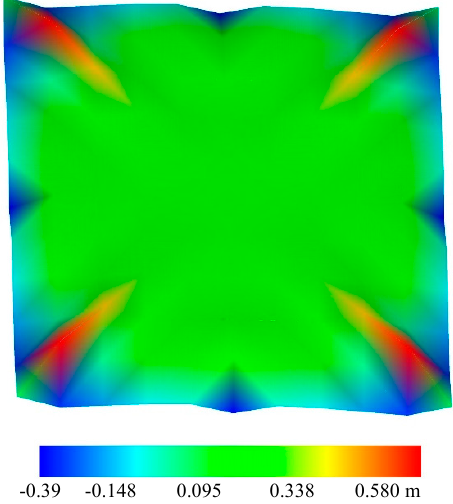
Figure 4. The distribution of the surface height difference of Scheme A and B at Step 120.